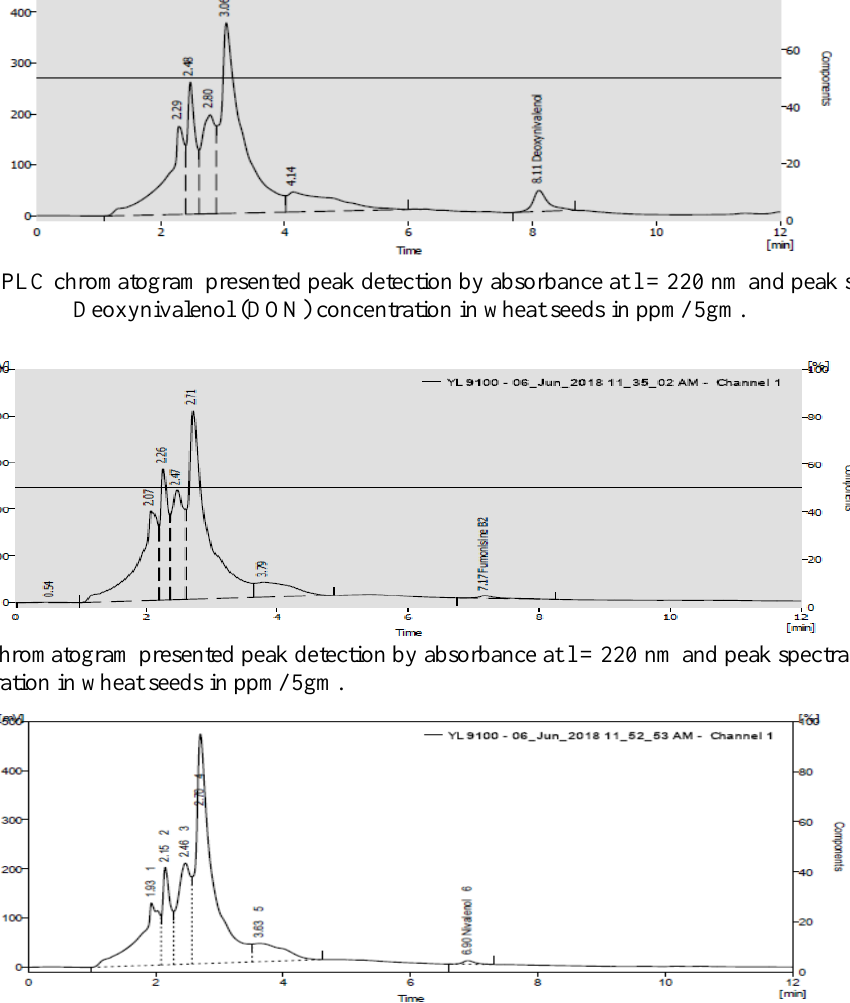
Figure, 3: HPLC chromatogram presented peak detection by absorbance at l = 220 nm and peak spectra for Nivalenol (NIV) concentration in wheat seeds in ppm/